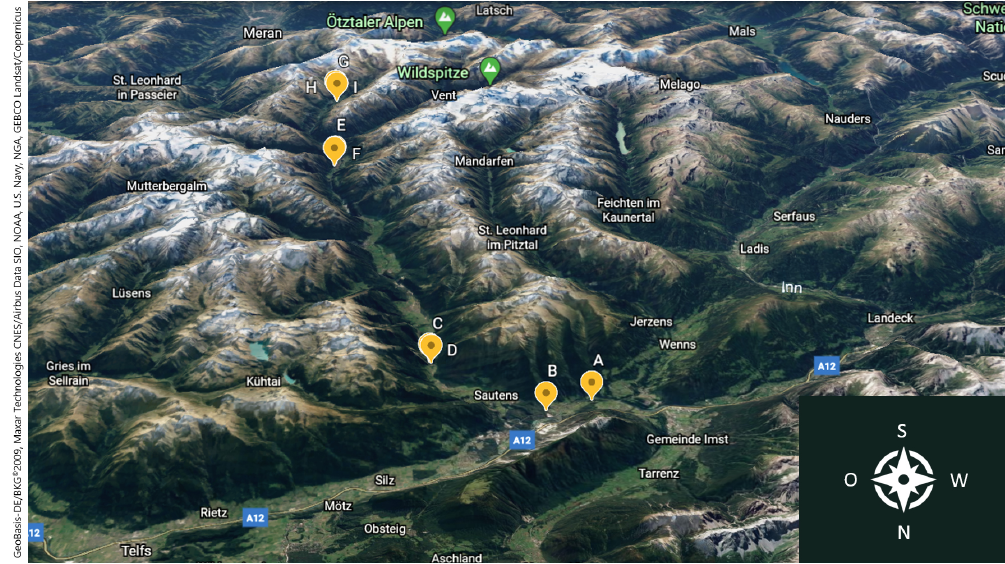
Figure 1. Locations of the sampled birches (yellow labels: Tree A to I) along the Ötztal valley in Tyrol, Austria. Picture adapted from Google Earth ©, https://earth.google.com/, last access: 10 February